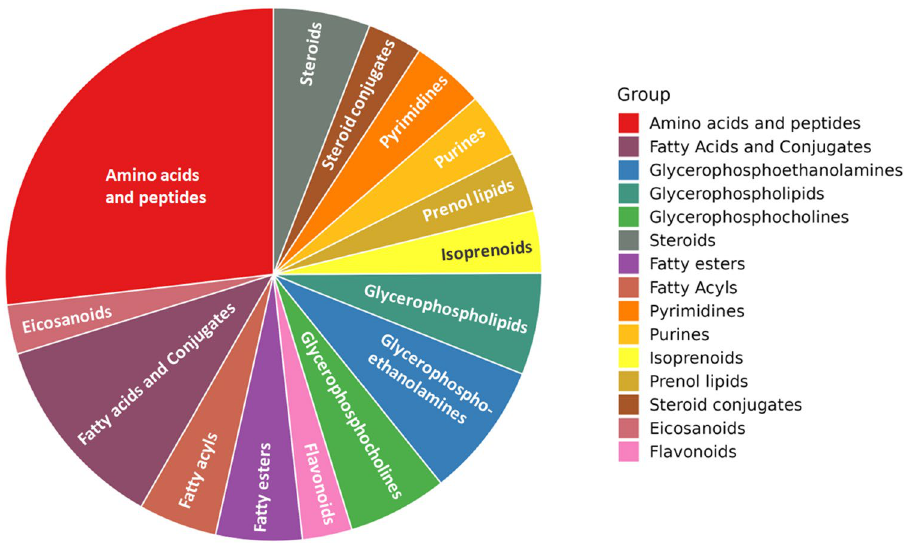
Figure 1. Pie chart showing the chemical classes annotated by untargeted metabolomics in the different plasma samples considering the classes of metabolites containing at least two